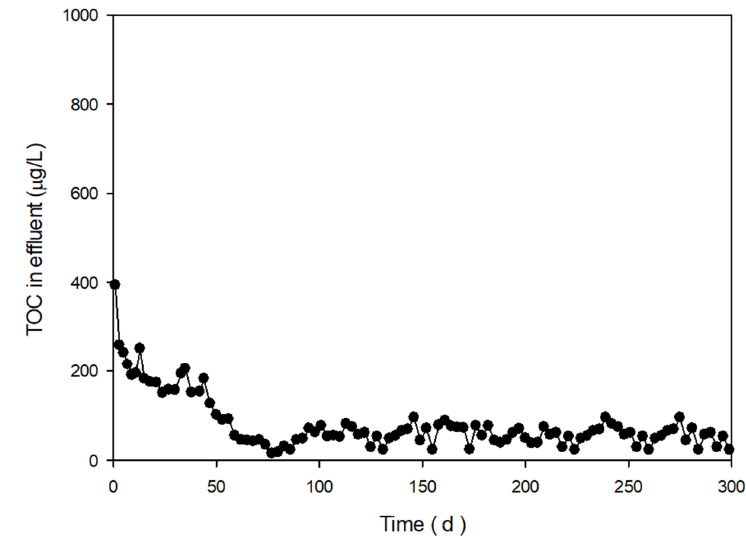
Figure 7. TOC leak test results of optimized pellets.